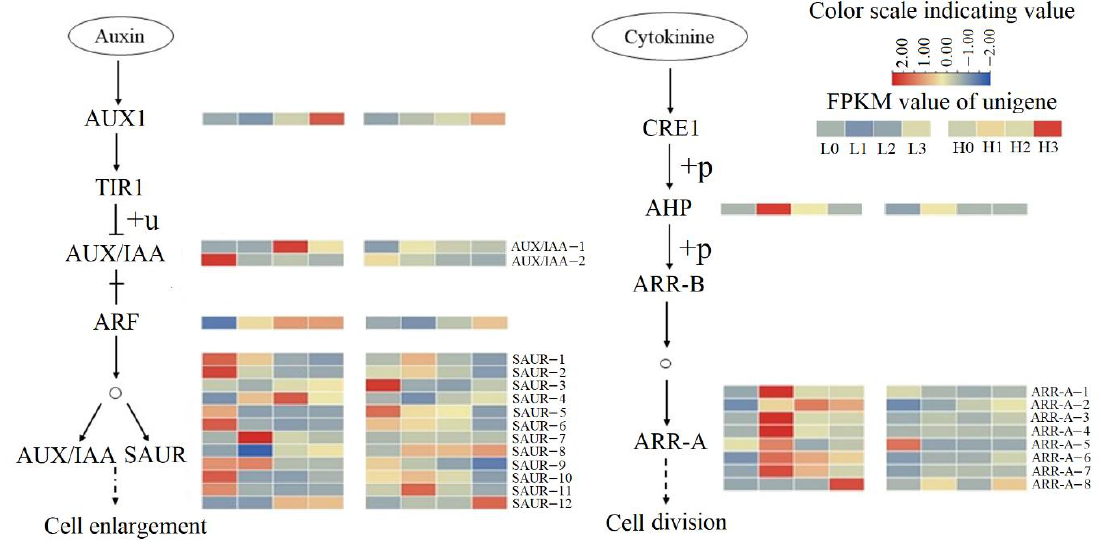
Figure 5. Auxin and cytokinin signaling pathways. FPKM values of unigenes of the enzymes are indicated from blue to red (low to high) across stage 0, stage 1, stage 2, and stage 3 under low R/FR ratio (L0, L1, L2, and L3) and high R/FR ratio (H0, H1, H2 and H3). Dotted lines indicate more than two reaction steps in the biological process. AUX1: auxin influx carrier; TIR1: transport inhibitor response 1; AUX/IAA: auxin/indole-3-acetic acid; ARF: auxin response factor; SAUR: small auxin up-regulated RNA; “†” means ARF dissociates from IAA; “+u” means ubiquitination; CRE1: cytokinin receptor; AHP: Arabidopsis histidine-containing phosphotransfer protein; ARR-B: Type-B Arabidopsis response regulator; AAR-A: Type-A Arabidopsis response regulator; “+p” means phosphorylation. “o” indicates DNA, which was bound by ARF to activate the transcription of AUX/IAA and SAUR, and also bound by ARR-B to activate ARR-A.